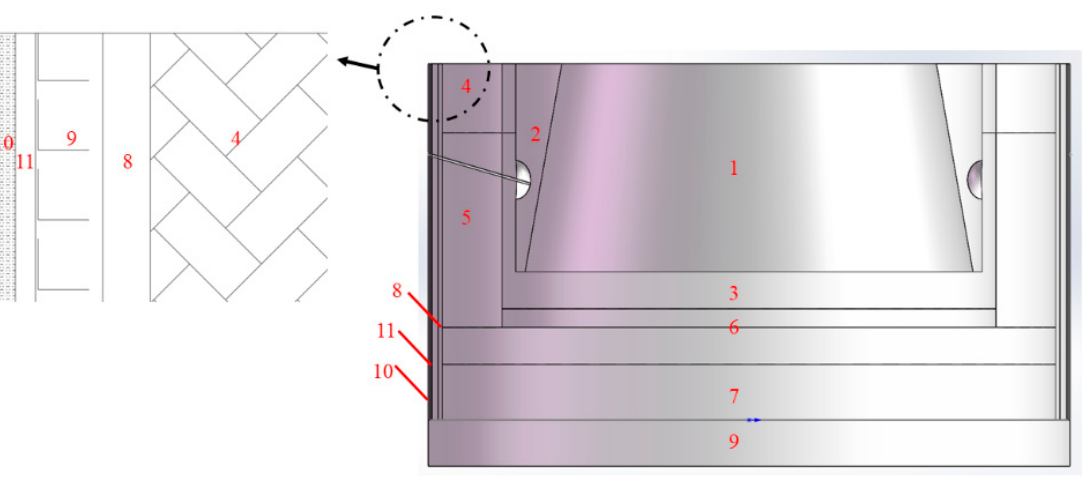
Table 3. Main geometrical parameters of the hearth of WISCO No. 1 blast furnace.